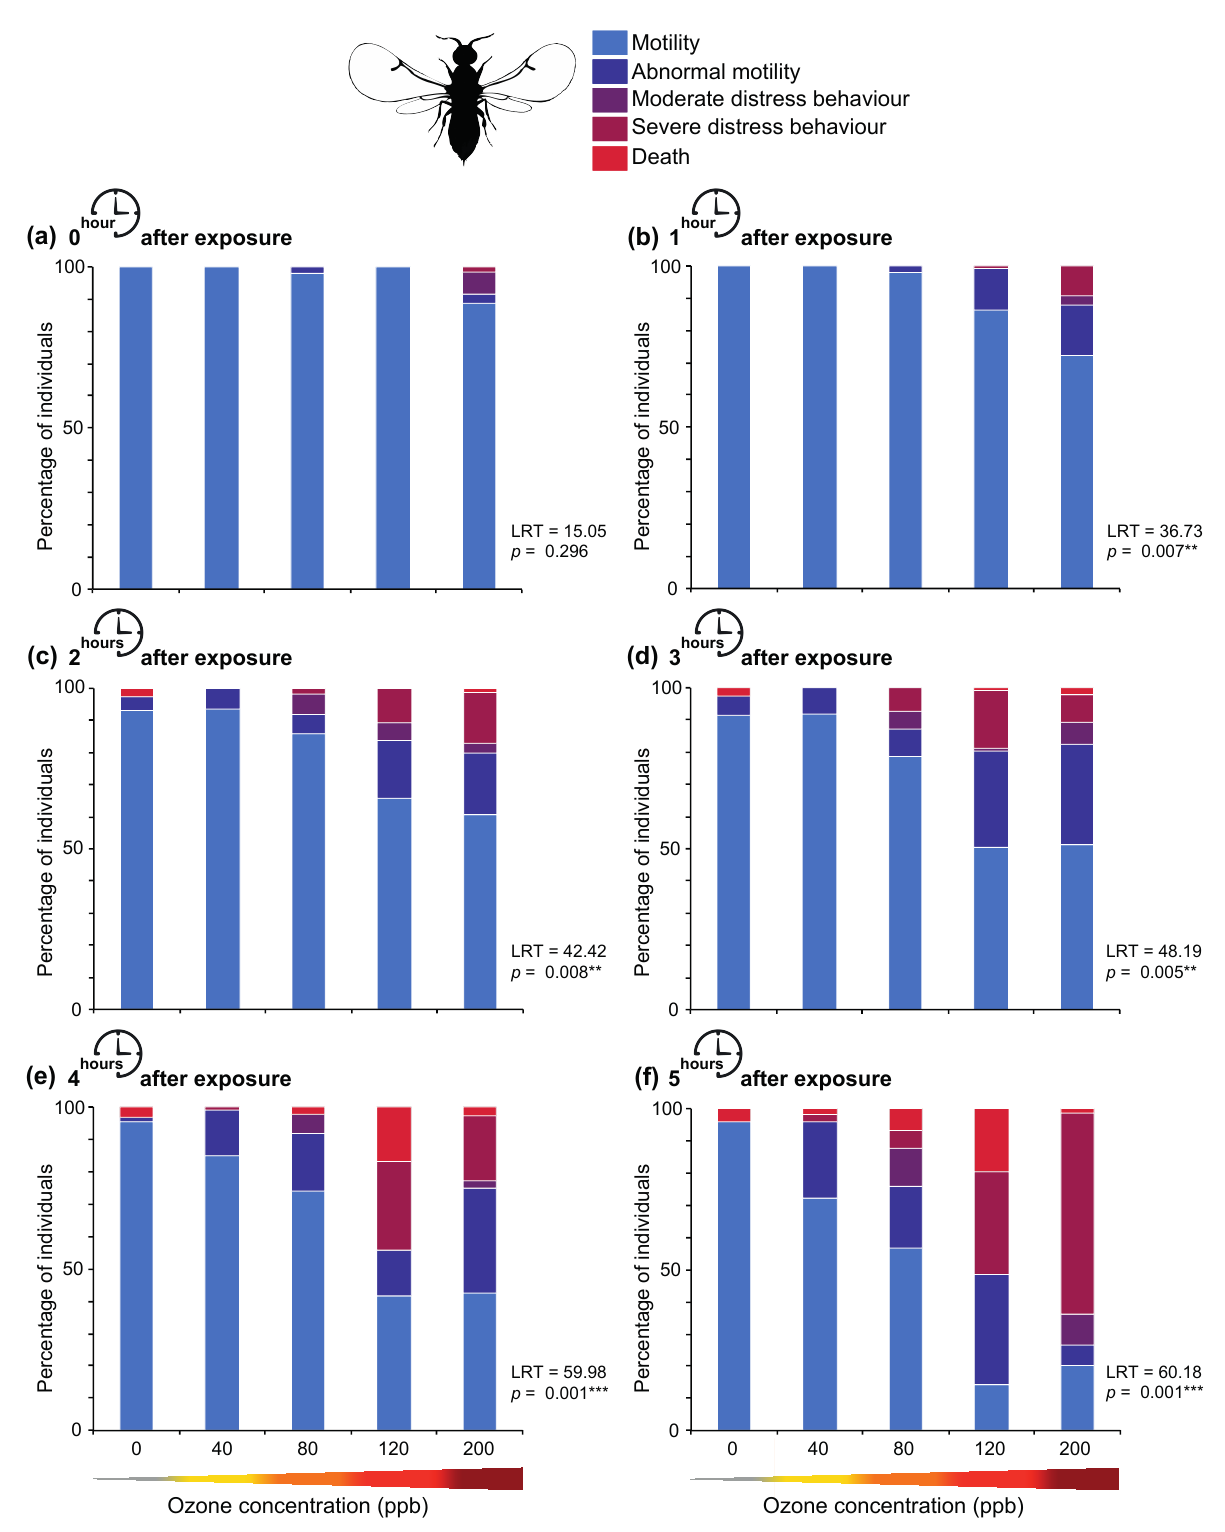
Figure 3. Behavior of fig wasps exposed to O 3 regimes for one hour (0, 40, 80, 120, and 200 ppb). After O 3 exposure, individuals were left in climate-controlled conditions and monitored hourly for 5 h to track survival and record behavioral responses. Each subfigure ( a – f ) corresponds to one of the monitoring moments. Five distinct behaviors were observed: (1) motility, (2) abnormal motility, (3) moderate distress behavior, (4) severe distress behavior, and (5) death. Data are expressed as the mean percentage of individuals displaying the different behaviors. Asterisks indicate significant differences (**, very significant, *** extremely significant) in the behavior of exposed fig wasps between O 3